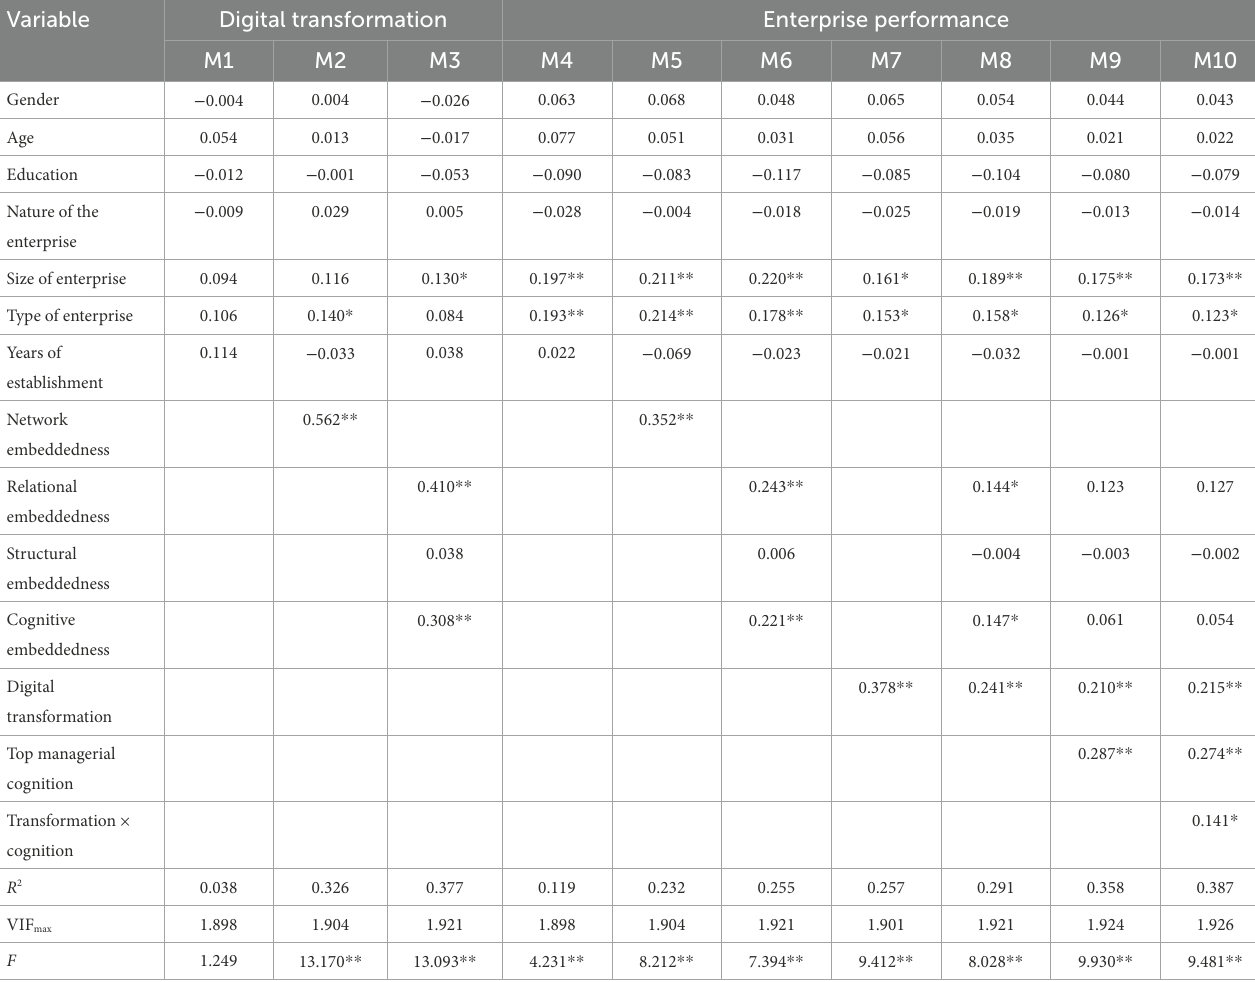
TABLE 4 Results of hypothesis